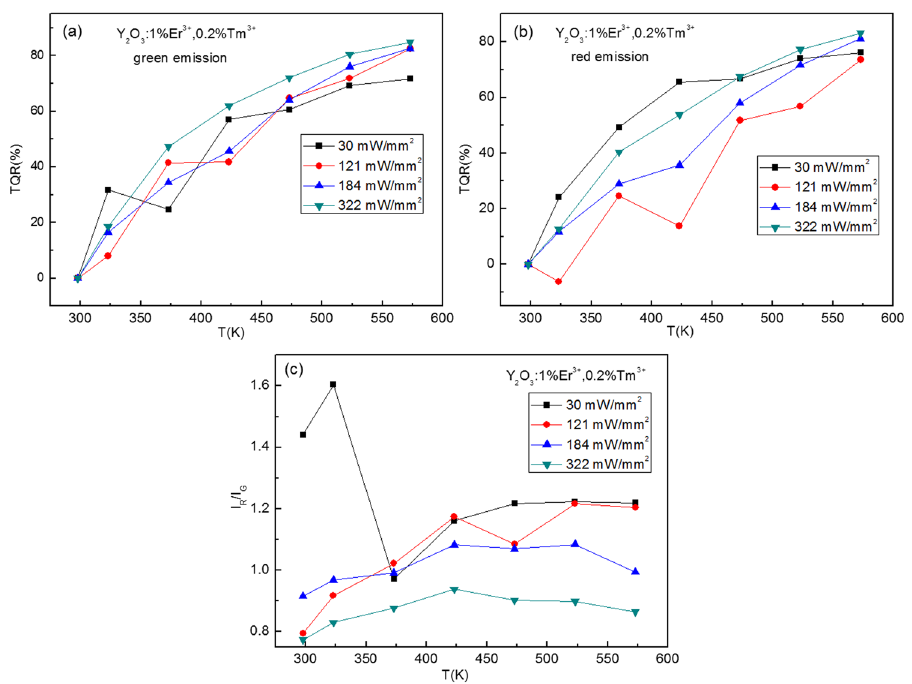
Figure 11. Excitation powers dependent TRQ of ( a ) green and ( b ) red emissions of Y 2 O 3 :1%Er 3 + , 0.2%Tm 3 + , and ( c ) red to green intensity ratio of Y 2 O 3 :1%Er 3 + , 0.2%Tm 3 +